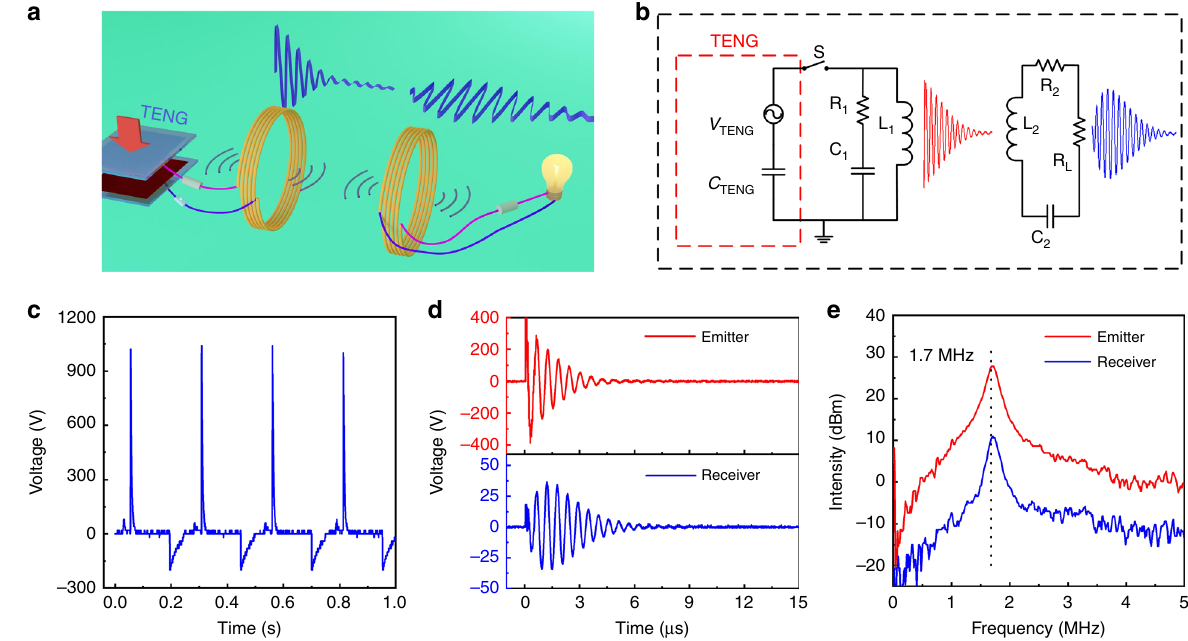
Fig. 1 Magnetic resonance coupled wireless TENG. a The schematic and b the equivalent circuit of the magnetic resonance-coupled wireless energy transmission system. c The typical voltage output of the contact-separation mode PA6/PDMS TENG with the microswitch under cyclic pressing. d The oscillating voltage signals and e their fast Fourier transformation spectra of the emitter and receiver modules of the MR-WTENG system. The working condition of the TENG for c , d , e is 50 N contact force, 4 Hz contact frequency, and 6 mm spacer distance between the two triboplates, and the transmission distance between the two coils is 5